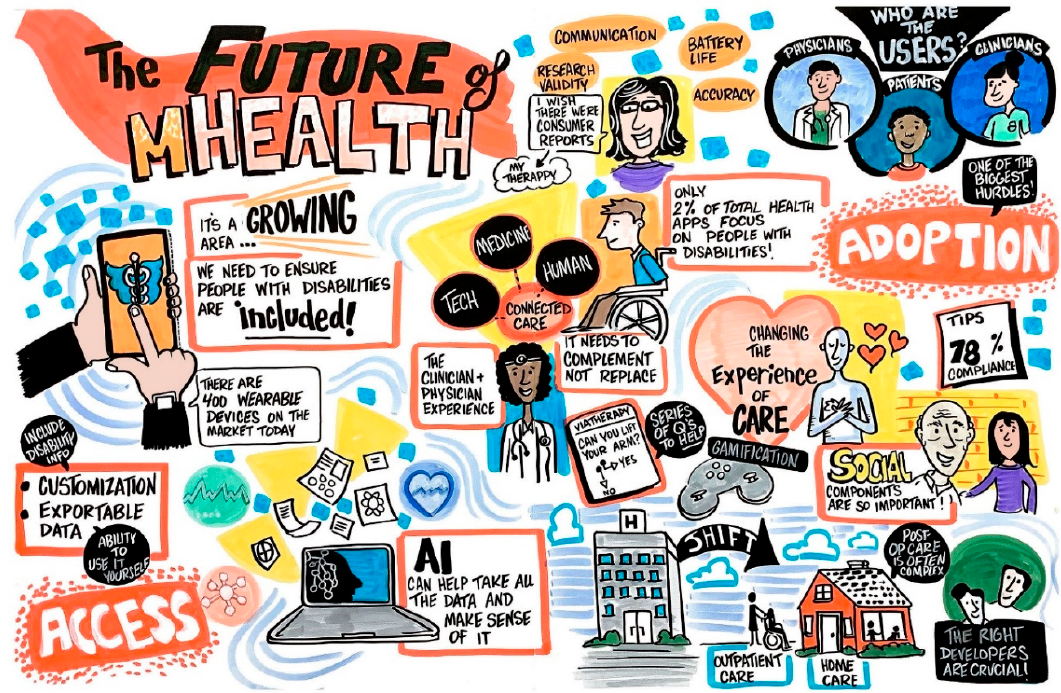
Figure 1. Graphical recording from the session on The Future of mHealth for People with Disabilities.